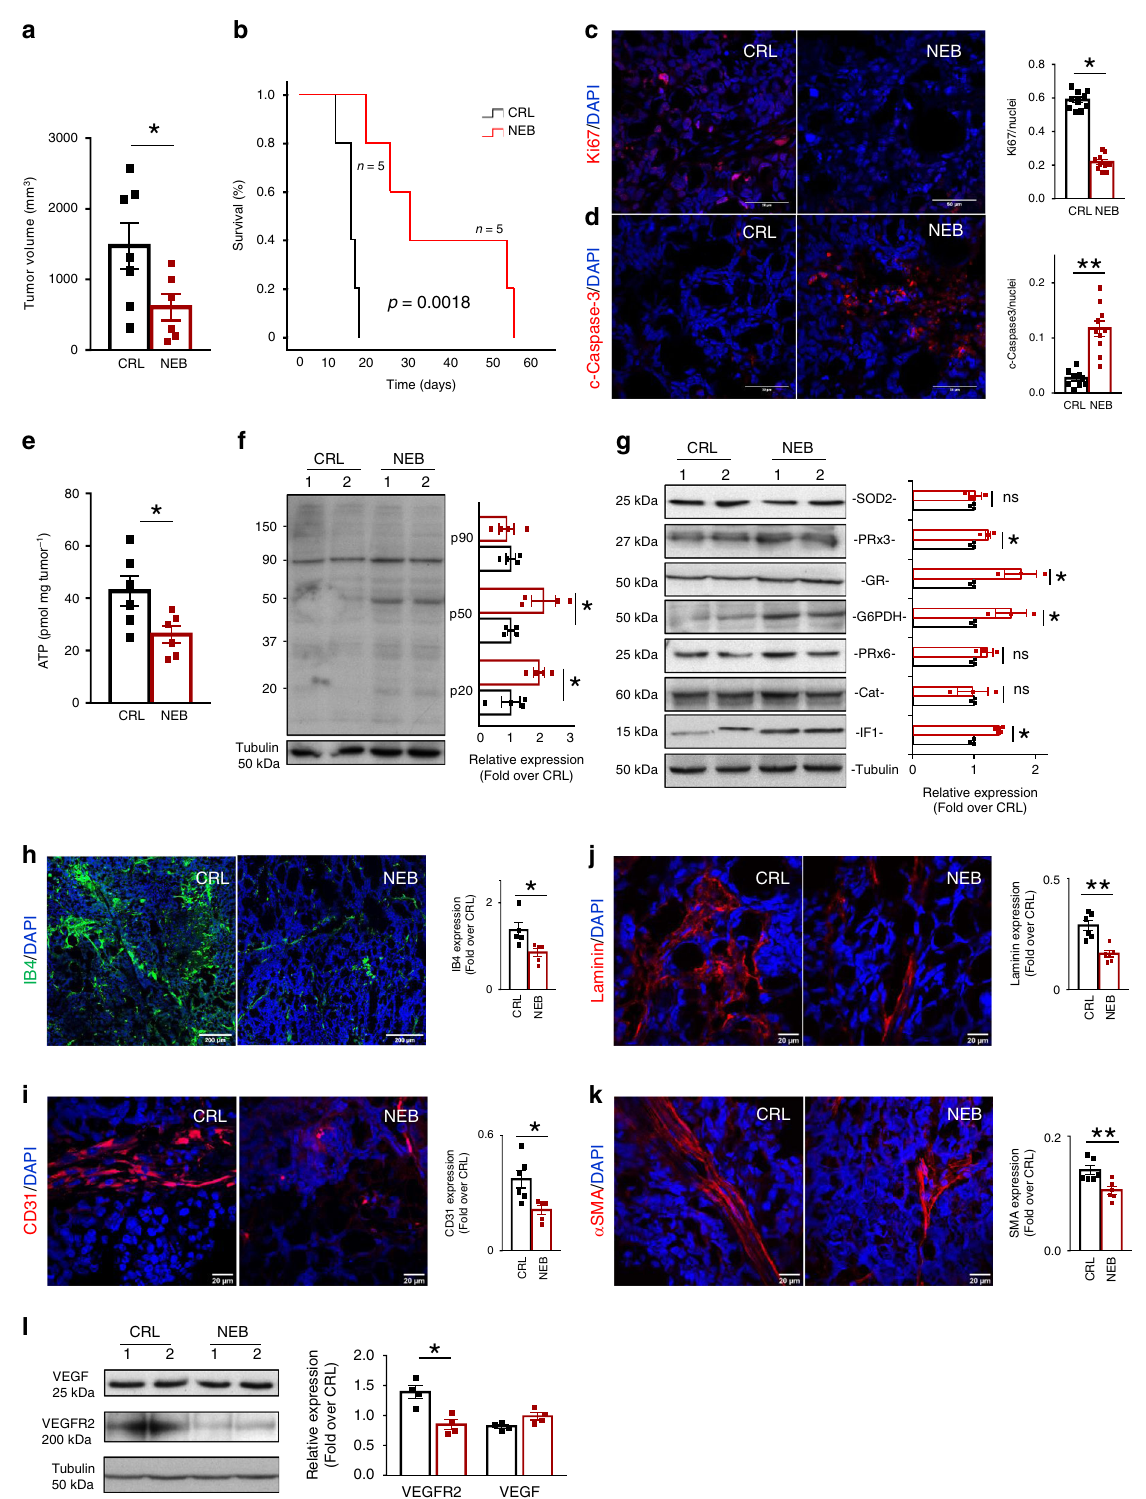
proliferation and enhances death of cancer cells growing in vivo (Fig. 9). Remarkably, in mice bearing colon carcinomas, life expectancy increased further when nebivolol was used in com- bination with 5FU, illustrating nebivolol ’ s ability to potentiate the activity of the classical anticancer colorectal drug. Basket trials are de fi ned as those including cancer patients with carcinomas from different tissue origins sharing a common